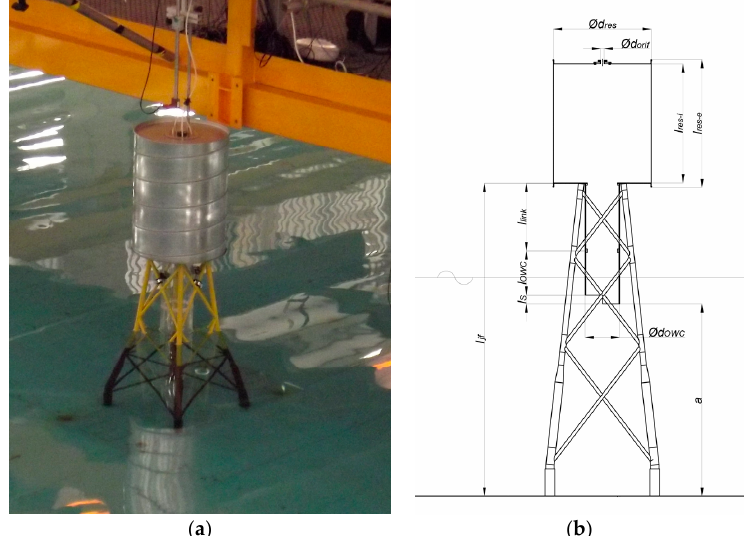
Figure 3. 1:50 model of the hybrid wind-wave energy converter: ( a ) during tests at the University of Plymouth’s COAST Laboratory, and ( b ) cross-sectional view of the model. Table 1. Model characteristics and dimensions.